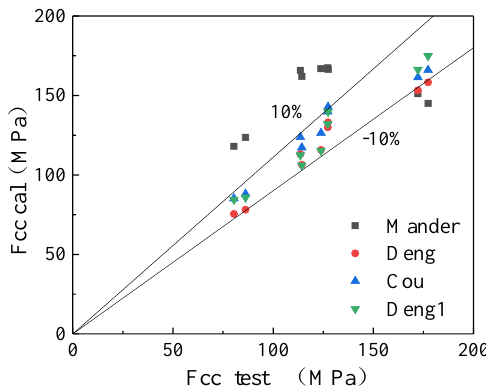
Figure 8. Stress scatter distribution diagram.